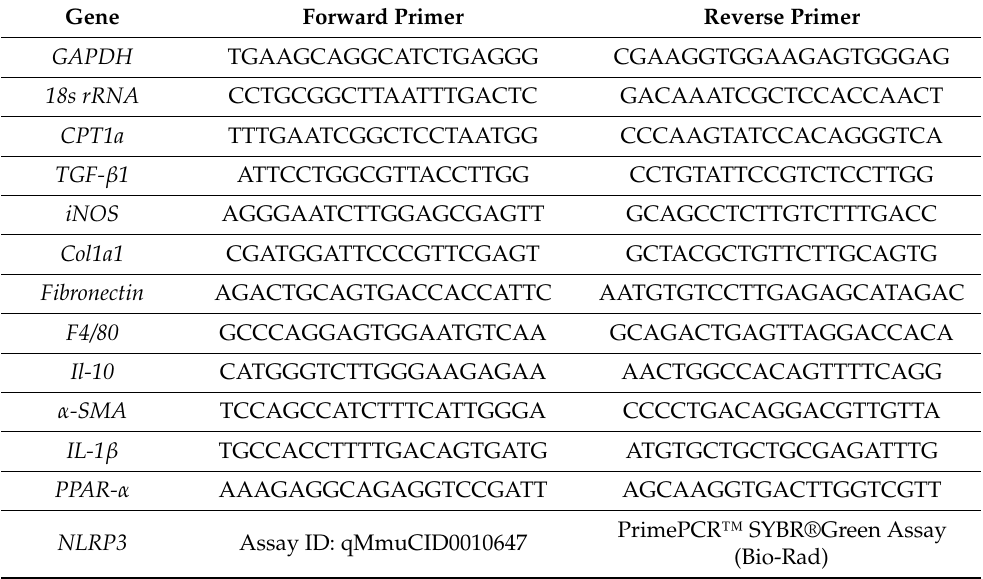
Table 1. Primers sequences used for